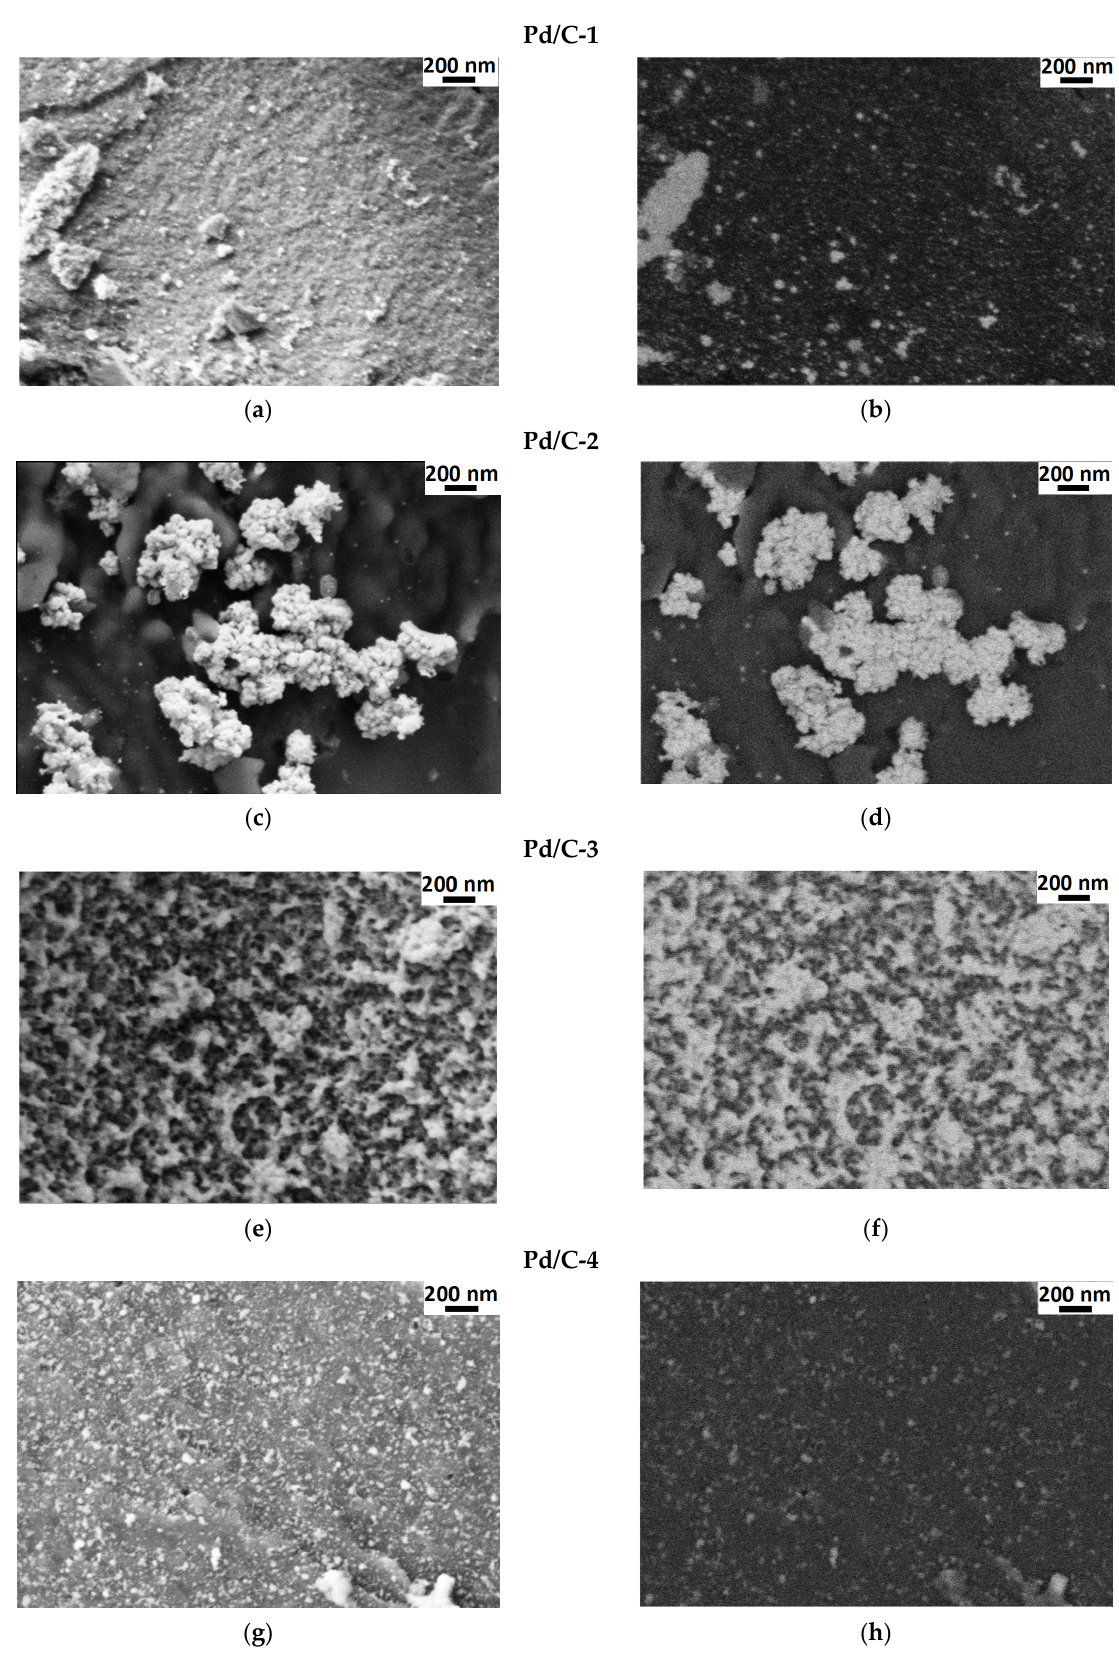
Figure 5. SEM images in secondary electron mode (left column) and backscattered electron mode (right column) of Pd/C-1 ( a , b ), Pd/C-2 ( c , d ), Pd/C-3 ( e , f ), and Pd/C-4 ( g , h )